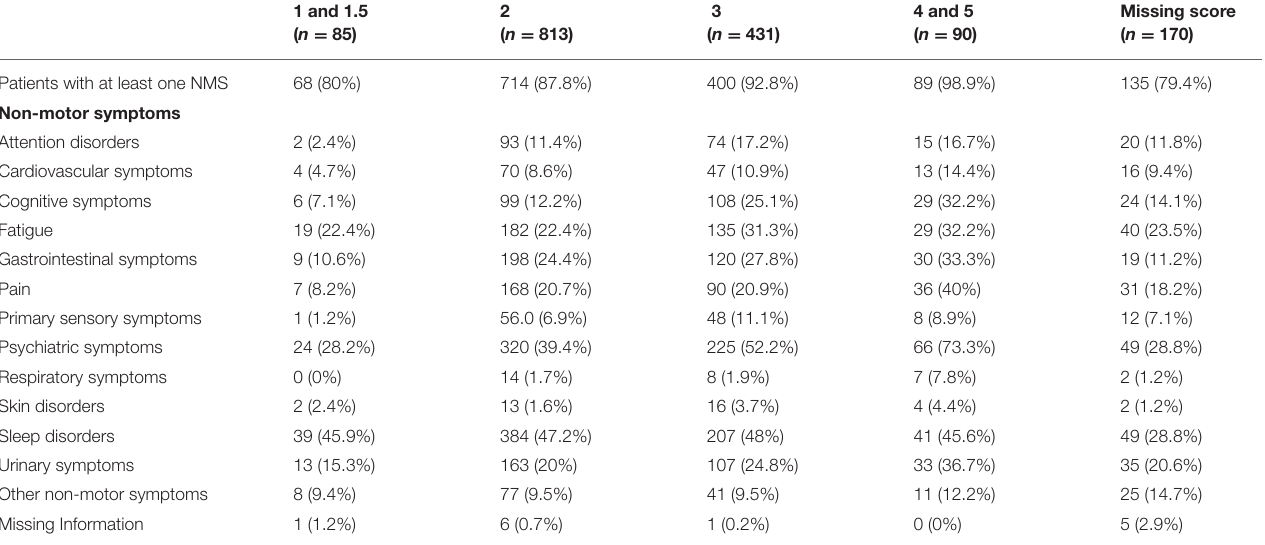
TABLE 4 | Distribution of non-motor symptoms in idiopathic Parkinson’s Disease blocking for “enrollment age” (percentiles). Patients with at least one